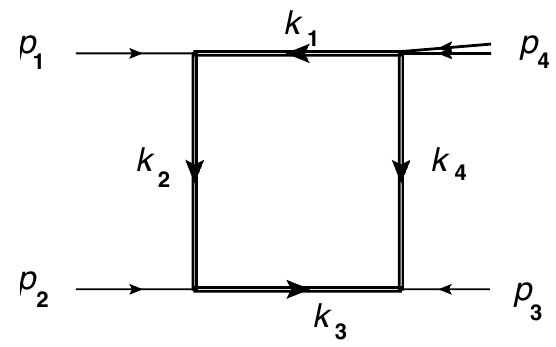
Figure 12 . The one-loop scalar box with one o(cid:11)-shell leg. Thick double lines denote massive